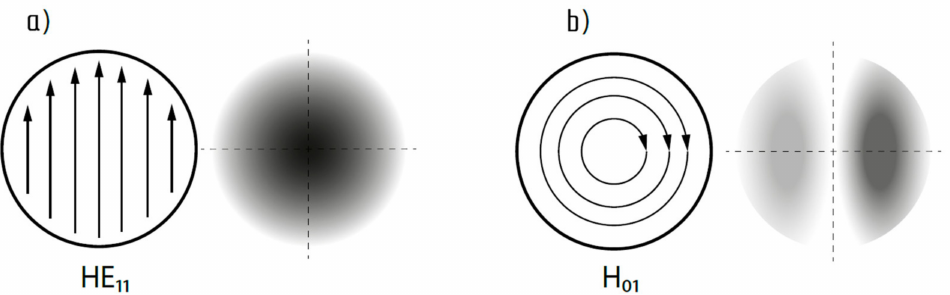
Figure 3. Parameters of the considered types of waves in the cross section of the stepped fiber core: ( a ) the lowest order mode—the fundamental LP 01 (or HE 11) and ( b ) an example of a higher order mode— LP 11 (or H 01) [34]; arrows illustrate the directions of the lines of force of the electric field for these types of waves as a component of light waves; shaded areas correspond to the amplitude profile of these